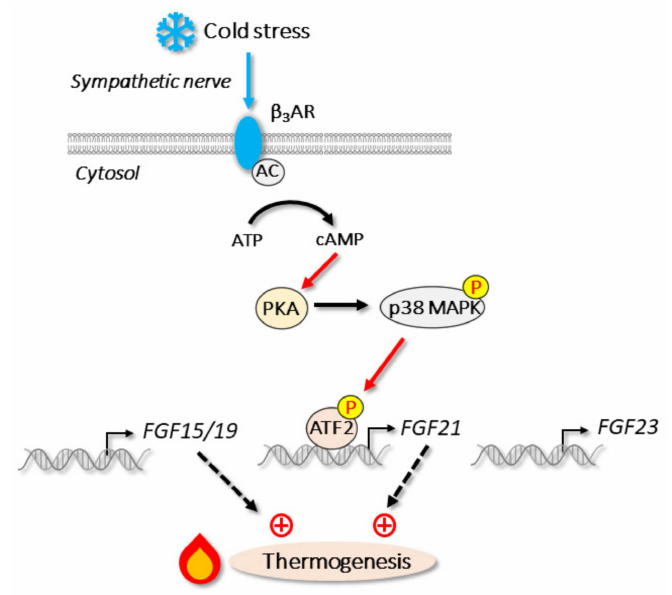
Figure 5. Cold stress and endocrine FGFs: upon cold stress, β 3 -adrenergic receptor ( β 3 AR) stimulates the production of second messenger cAMP through adenylate cyclase (AC). Subsequent pathway actives p38 MAPK and transcription factor ATF2, which induces FGF21 expression during cold